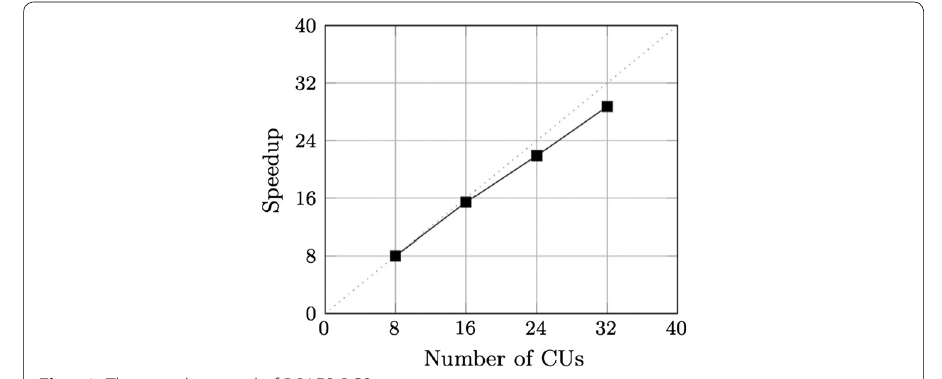
Fig. 12 The speedup trend of